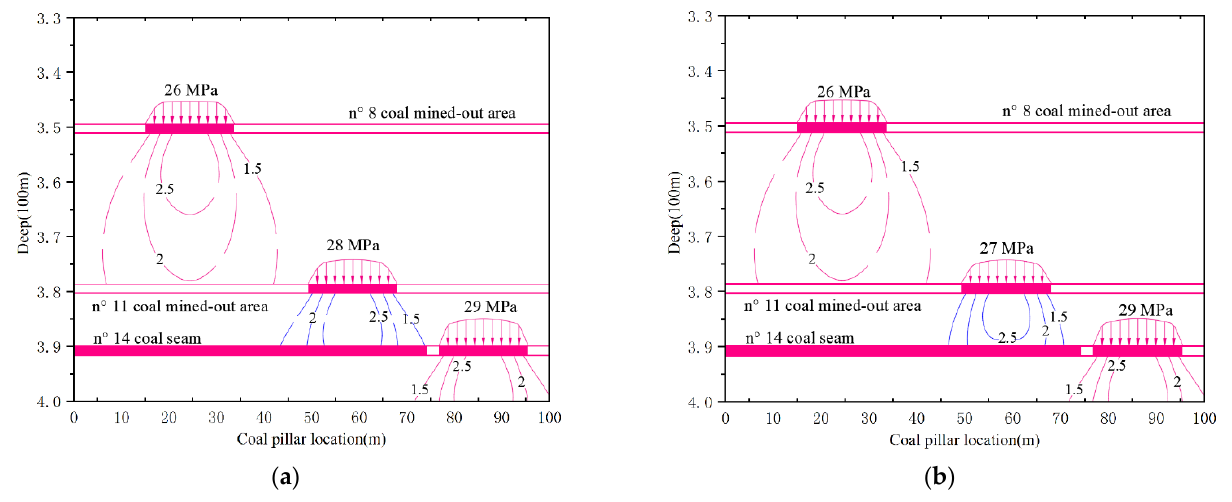
Figure 8. Coal pillar stress influence range. ( a ) n° 11 residual coal pillar stress curve distribution before weakening; ( b ) n° 11 residual coal pillar stress curve distribution after weakening.